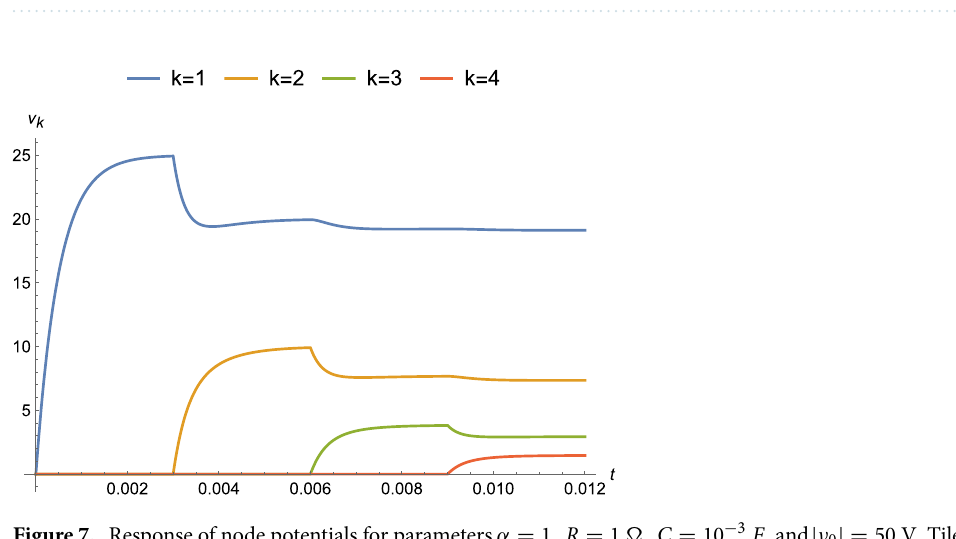
Figure 6. Response of first node potential in the seed tile for α = 1, R = 1 � , C = 10 − 3 F , and | ν 0 | = 50 V . The second tile attaches to the seed at t = 0.003 s, causing the node potential at node 1 ( ν 1 ) to undergo a transient. The steady-state (ss) DC value 25 V (top line) for the seed alone is shown for reference.